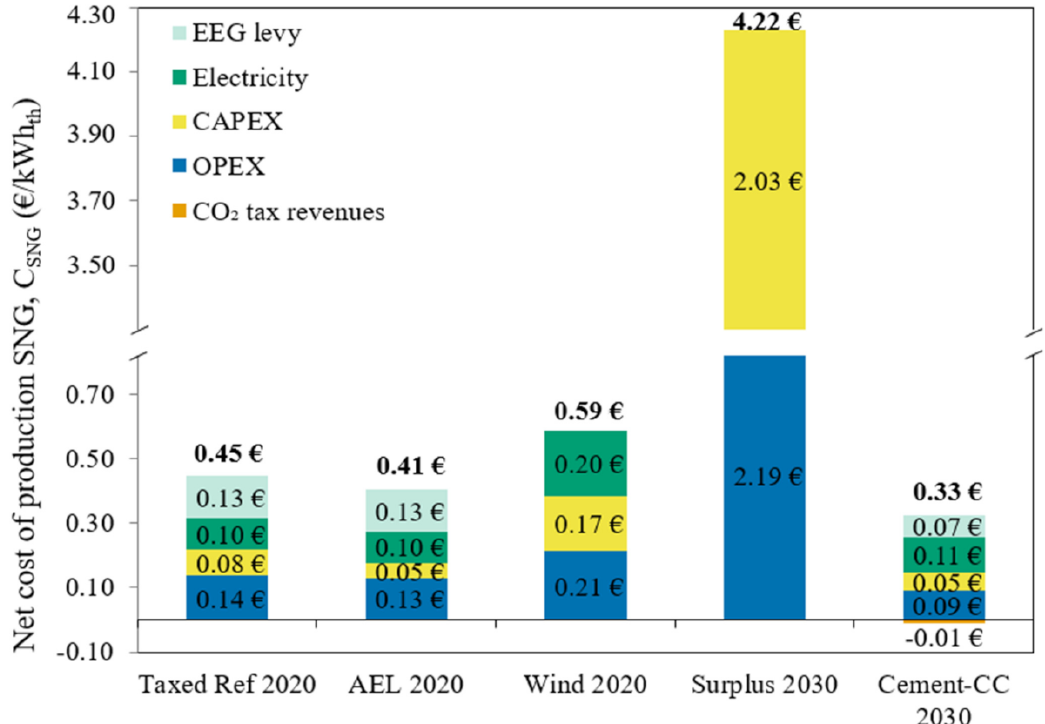
Figure 7. SNG net cost of production per